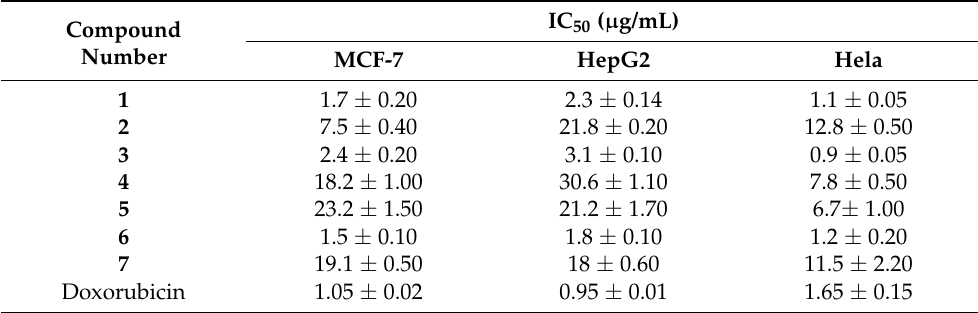
Table 3. Summary of cytotoxic effects (IC 50 , µ g/mL) in three cancer cell lines of the isolated com- pounds ( 1 – 7 ). SRB assay was used and the cells were treated with different concentrations of different isolated materials for 72 h. Values in the table represent the means of IC 50 from 3 independent experiments, with SE ranging from 19% to 33% of the average values. The tested cell lines of human origin were: MCF-7 (breast adenocarcinoma), HepG2 (hepatocellular carcinoma), and HeLa (cervix